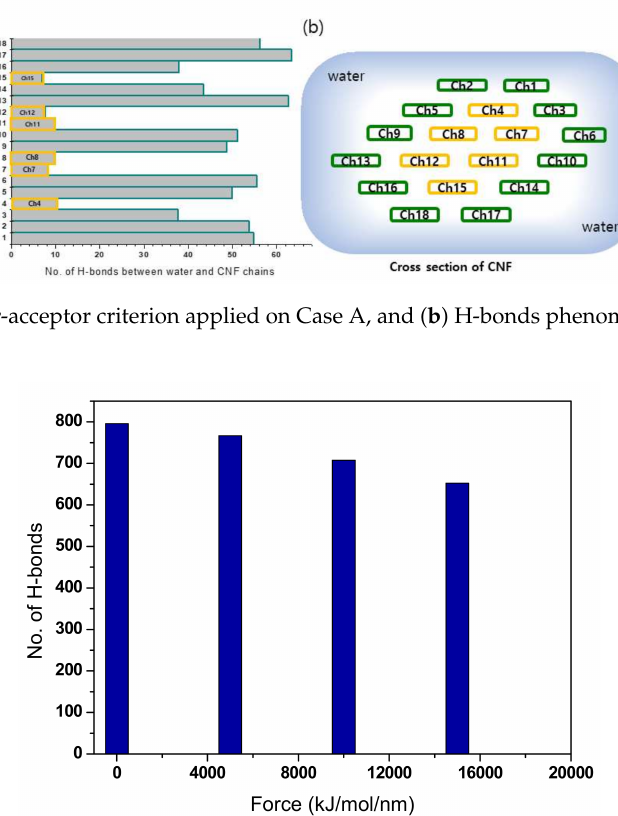
Figure 8. H-bonds during half pull simulation for 200